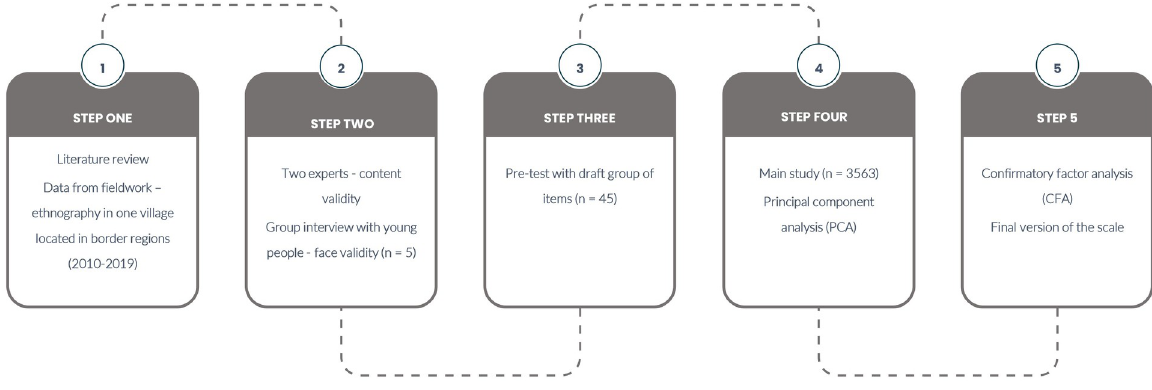
Fig 1. Development and validation of the